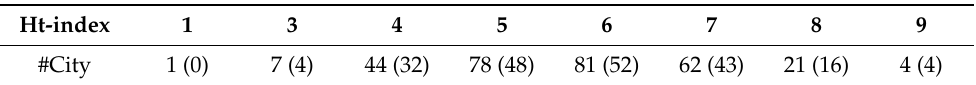
Table 3. Ht-indexes of street connectivities for 298 cities. (Note: the number in brackets indicates the number of cities whose street connectivities pass the power-law